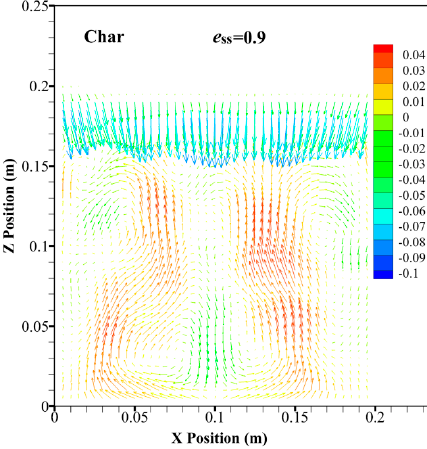
Figure 5. Time-averaged particle velocity distribution of the flotsam for e ss = 0.9 (the color legend represents the axial velocity of the particles).